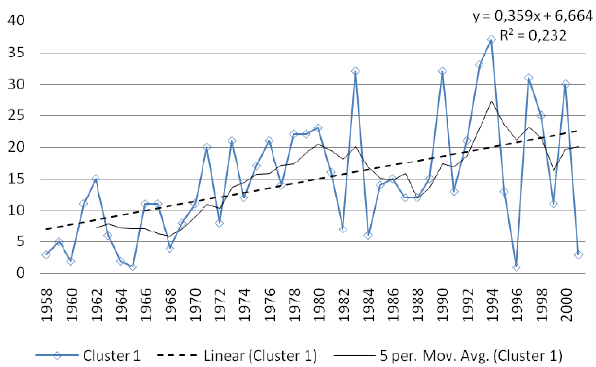
Fig.9. Frequency of appearance of Cluster 9, a 5-year moving average and a linear fit. Fig. 9. Frequency of appearance of Cluster 9, a 5-year moving av- erage and a linear